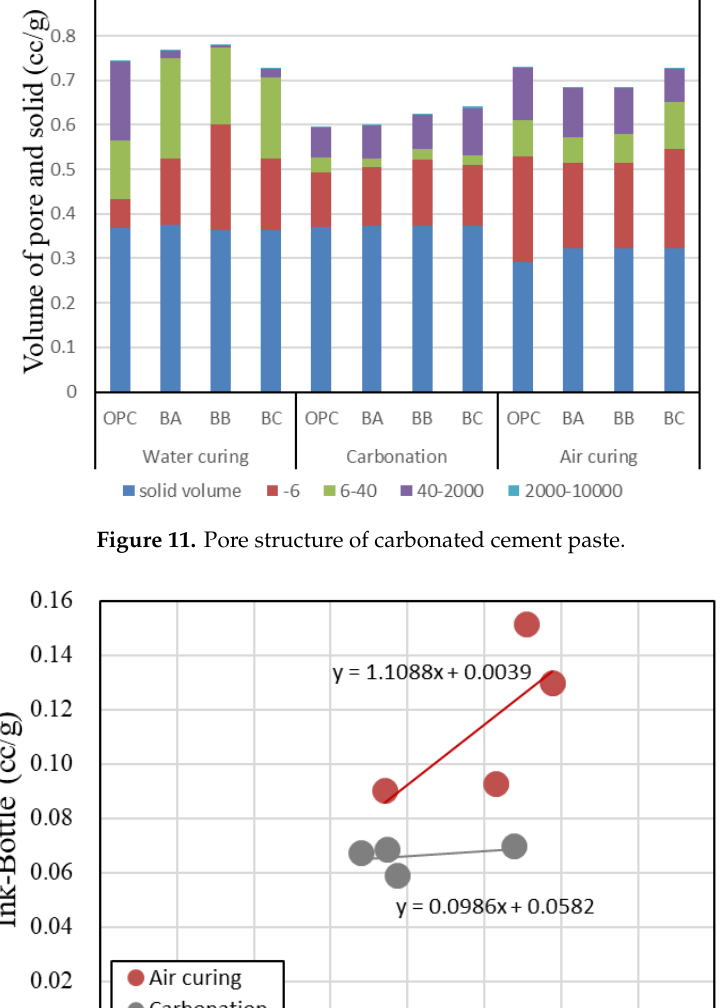
Figure 11. Pore structure of carbonated cement paste.